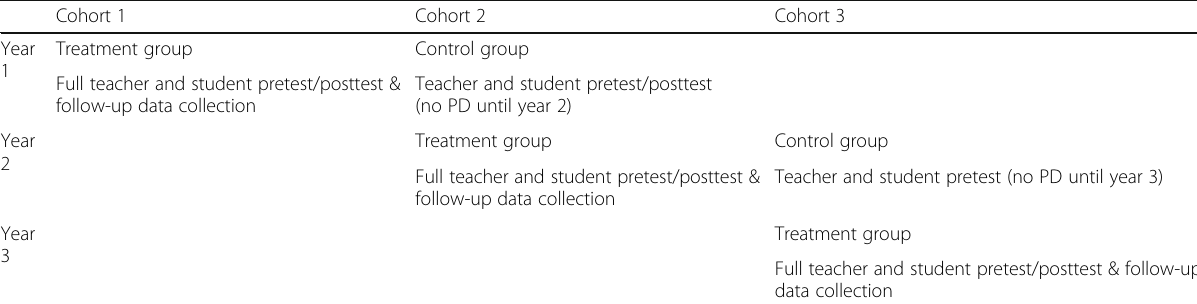
Table 1 Research design: quasi-experimental design delayed approach